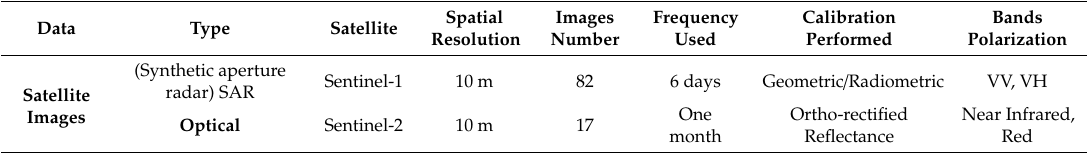
Table 1. Summary of the used remote sensing